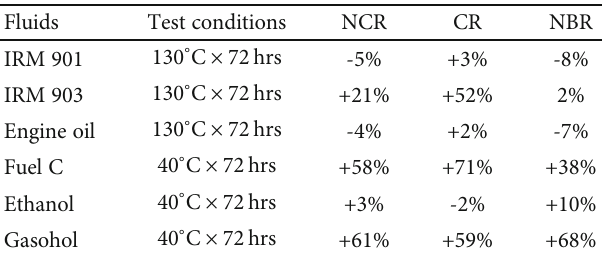
Table 5: Resistance to volume swelling ( Δ V , %) of vulcanizates of acrylonitrile-chloroprene rubber (NCR), chloroprene rubber (CR), and nitrile rubber